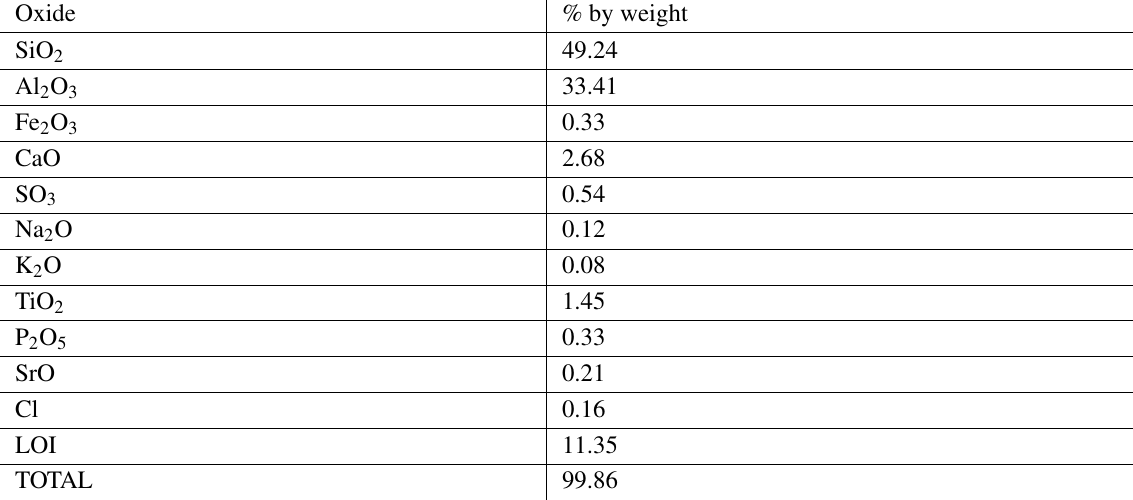
Table 1. Chemical analysis of clay